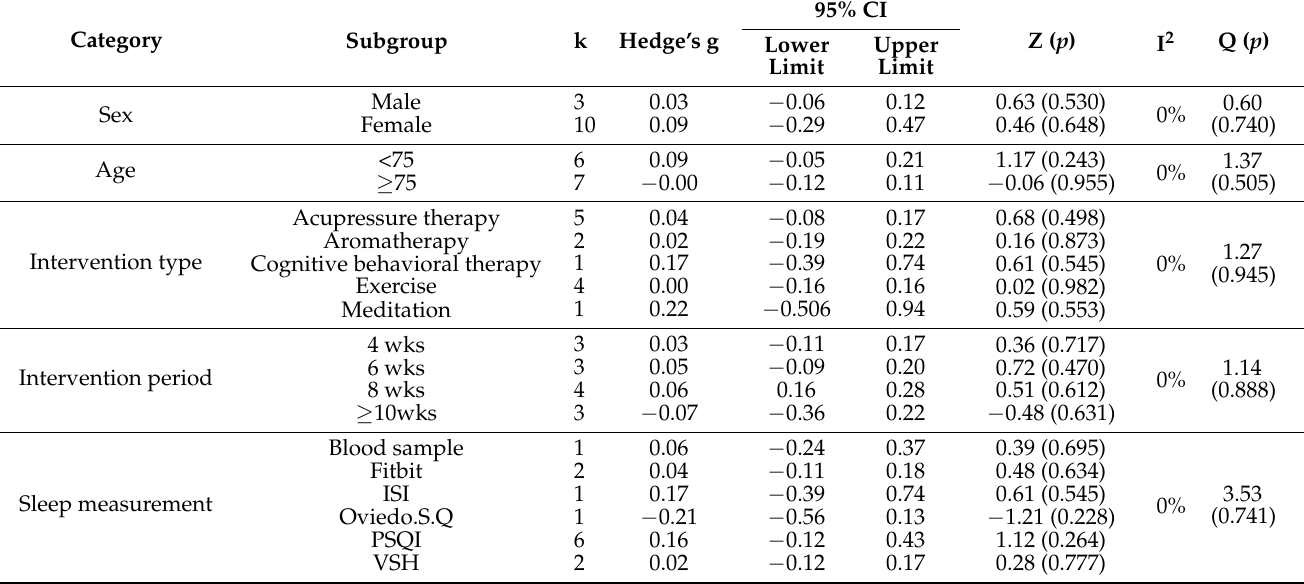
Table 3. Effects of moderator variables.